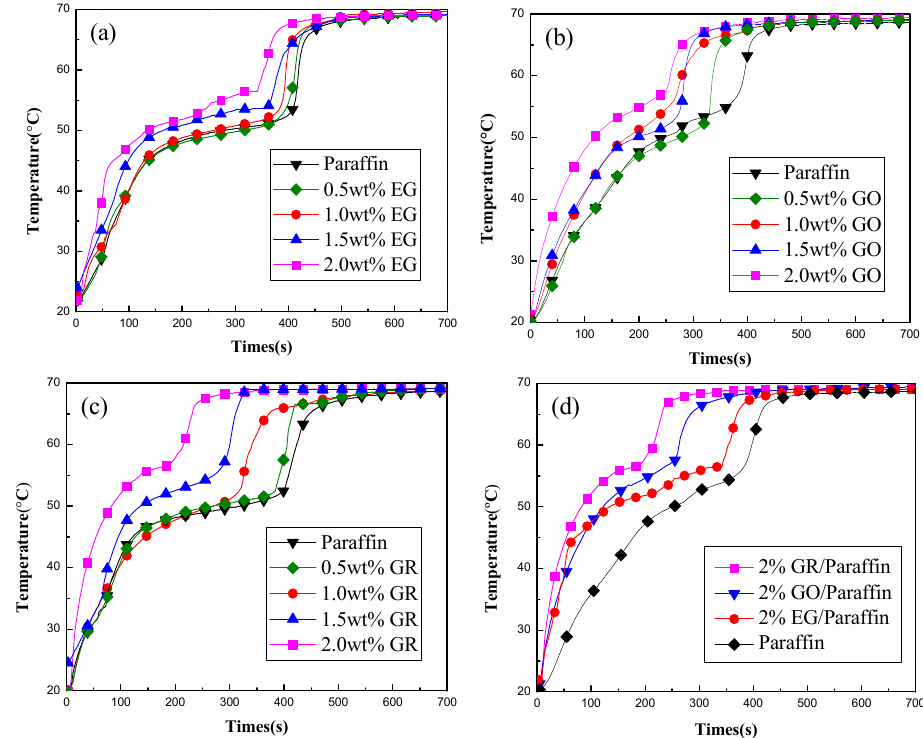
Figure 7. Melting curves of pure PCM and composite PCM with ( a ) EG as additives, ( b ) GO as additives, ( c ) GR as additives, ( d ) di ff erent additives at a concentration of